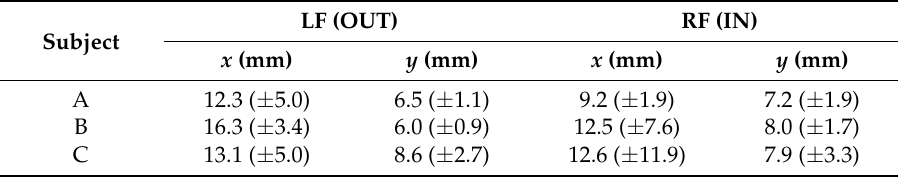
Table 5. Root-mean-square error (RMSE) of center of pressure (COP) comparing measurements from the Nintendo Wii Balance Board (WBB) with those from the force plate while walking along the curved path (clockwise—CW).